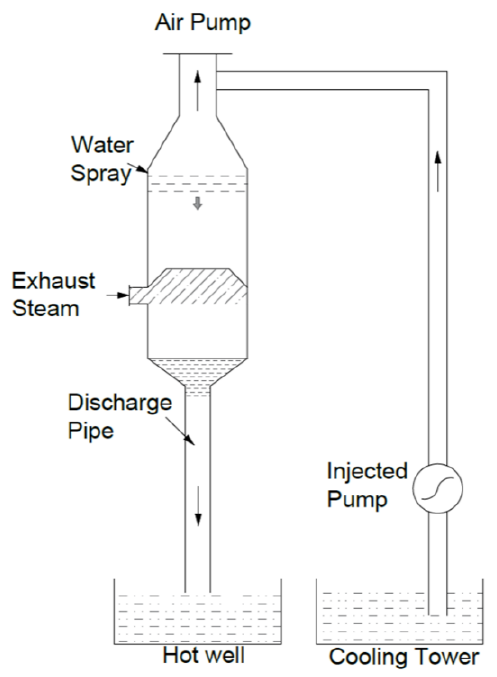
Figure 4. High-level counter-flow jet type